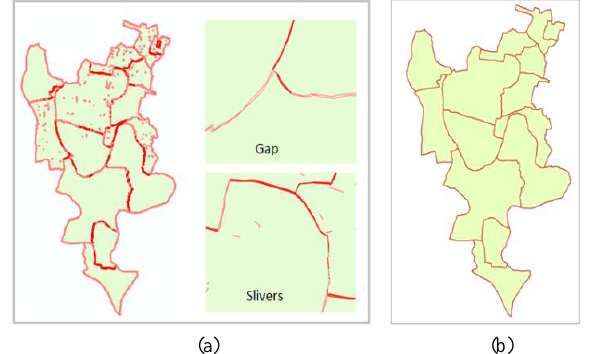
Figure 7, village 'Pulletikurru' is mapped to a single panchayat